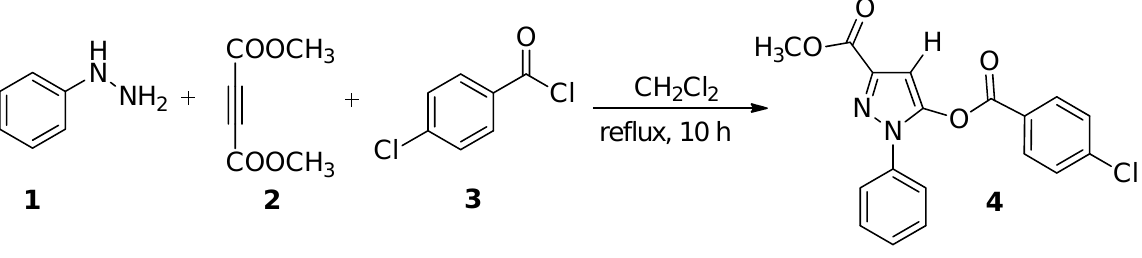
Figure 1. Synthesis of methyl 5-(4-chlorobenzoyloxy)-1-phenyl-1 H -pyrazole-3-carboxylate